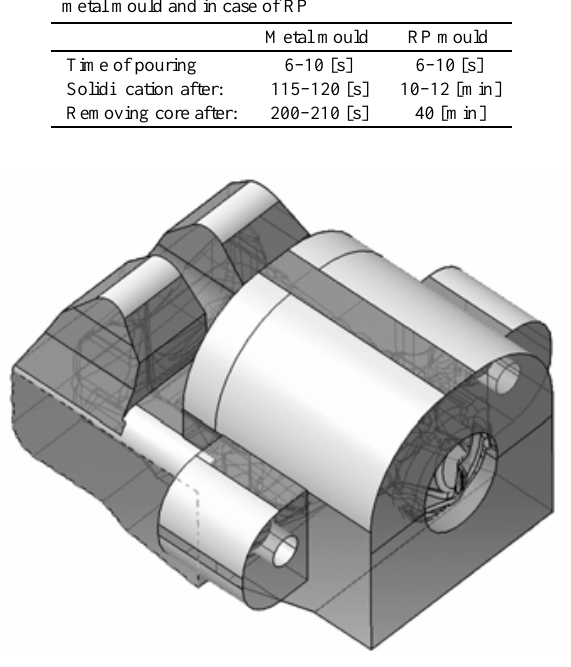
Fig. 1. A CAD draw of the